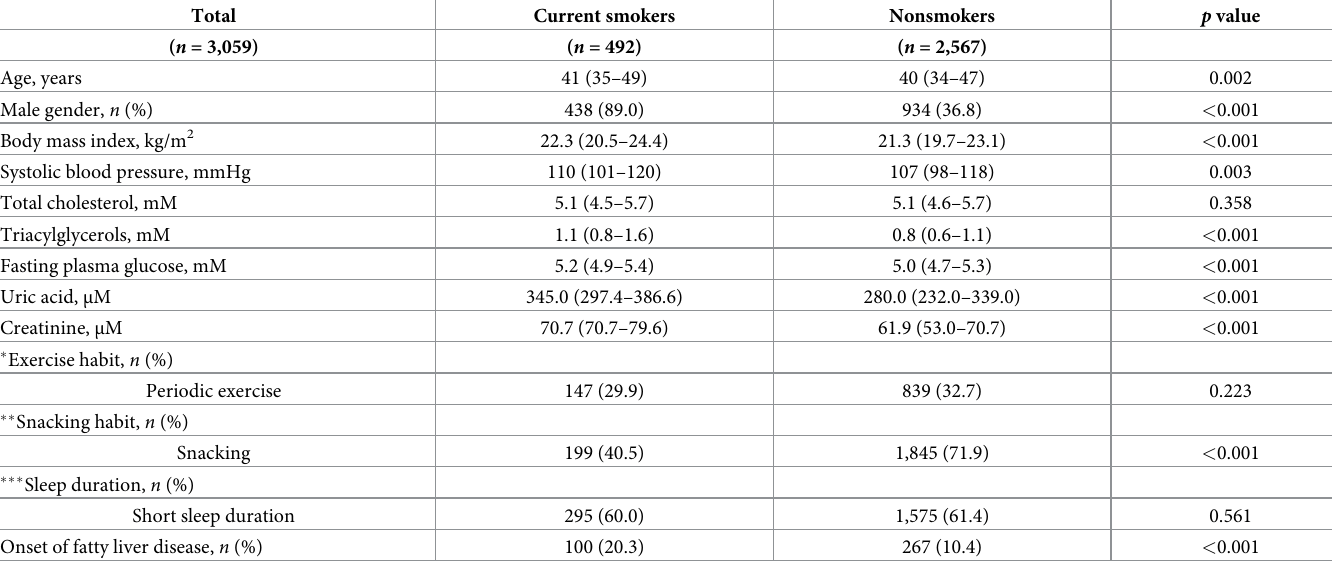
Table 2. Baseline characteristics of and the incidence rate of fatty liver in the low alcohol consumption